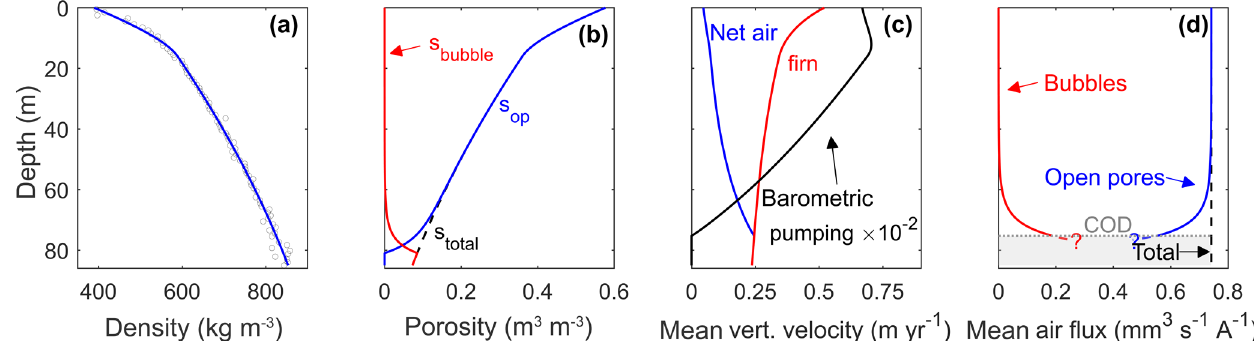
Figure 3. Firn conditions and modeled velocities profiles at WAIS Divide. (a) Density fit to observed data (data from Battle et al., 2011); (b) open, bubble (i.e., closed), and total porosity; (c) horizontally averaged barometric pumping velocity (i.e., time–mean horizontal average of | u b | , black), horizontally averaged net air velocity ( w firn + w r , blue), and firn velocity ( w firn , red); (d) mean air flux in open pores (blue) and bubbles (red).